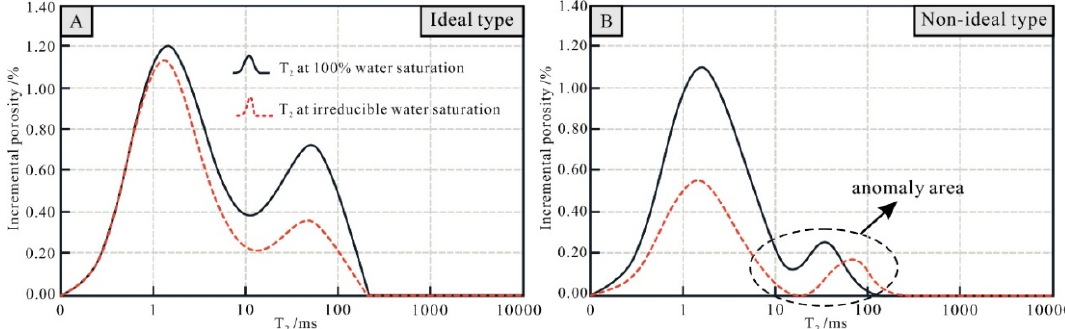
Figure 9. The model of NMR T 2 spectrum distribution on "diffusion coupling" effect. ( A ) Ideal type (isolated pore system); ( B ) Non-ideal type.